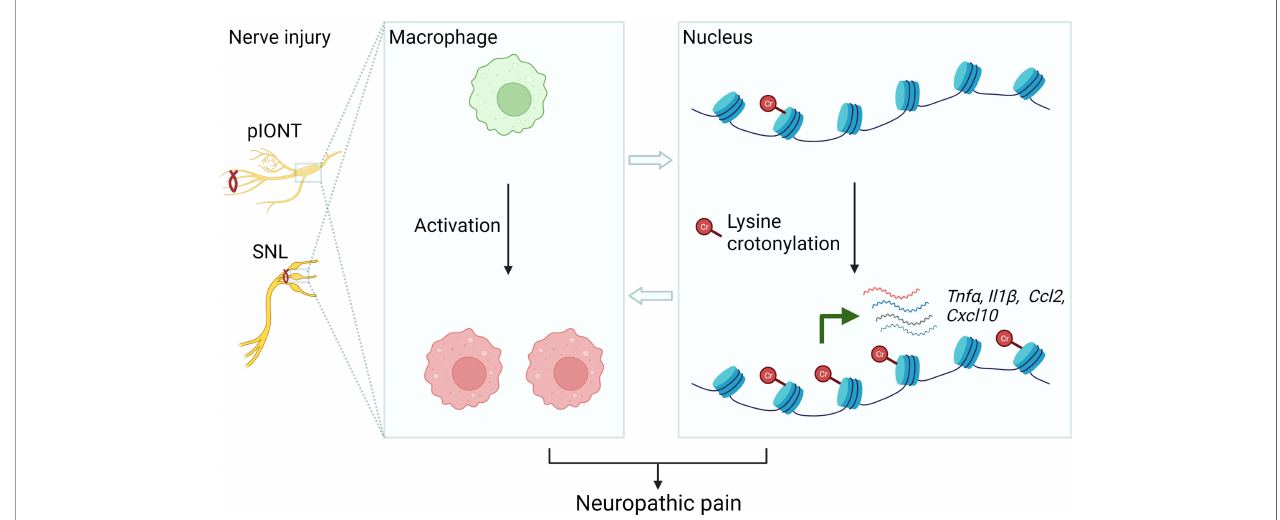
FIGURE 9 | Schematic diagram illustrating the possible mechanism of KCR in peripheral nerve injury-induced neuropathic pain. The left panel represents establishing the facial and somatic neuropathic pain animal models. The middle panel illustrates that peripheral nerve injury induces macrophage activation in TG or DRG. The right panel schematically indicates histone lysine crotonylation increased in macrophages after injury, resulting in the transcriptional enhancement of Tnf a , Il1 b , Ccl2 and Cxcl10 . These processes ultimately cause neuropathic